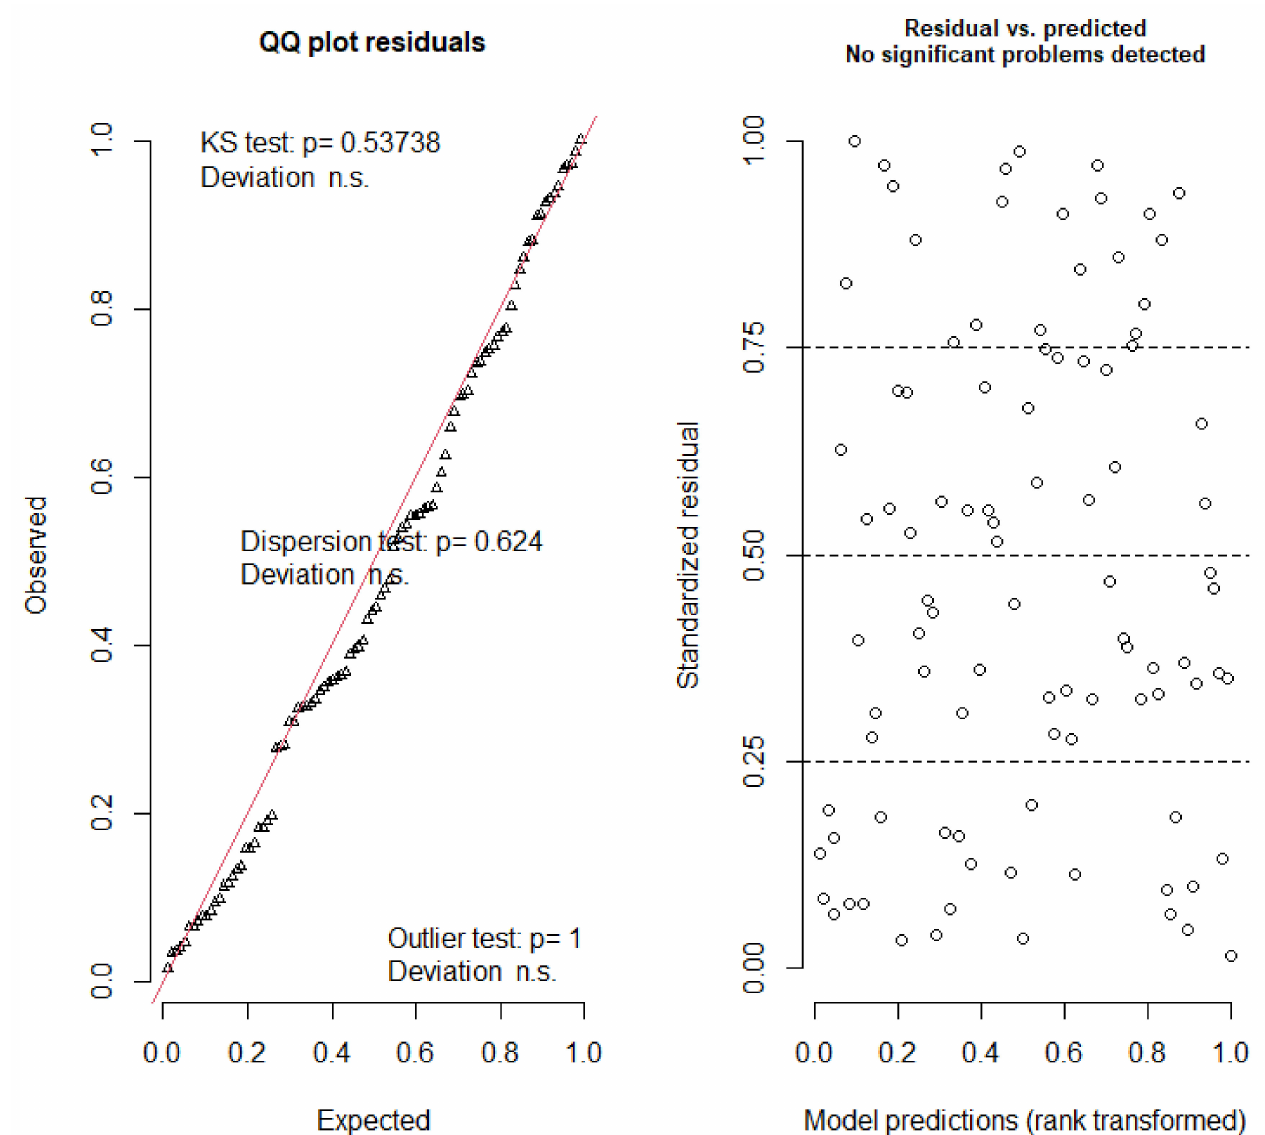
Figure A2. Q-Q plot and the residuals versus the predicted for the mean catch model of Lucilia sericata